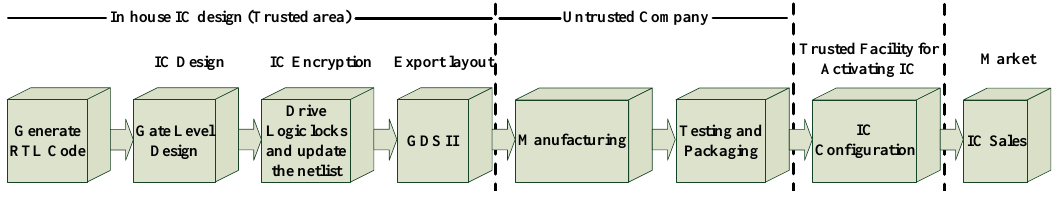
Figure 2. An integrated circuit design flow with logic encryption